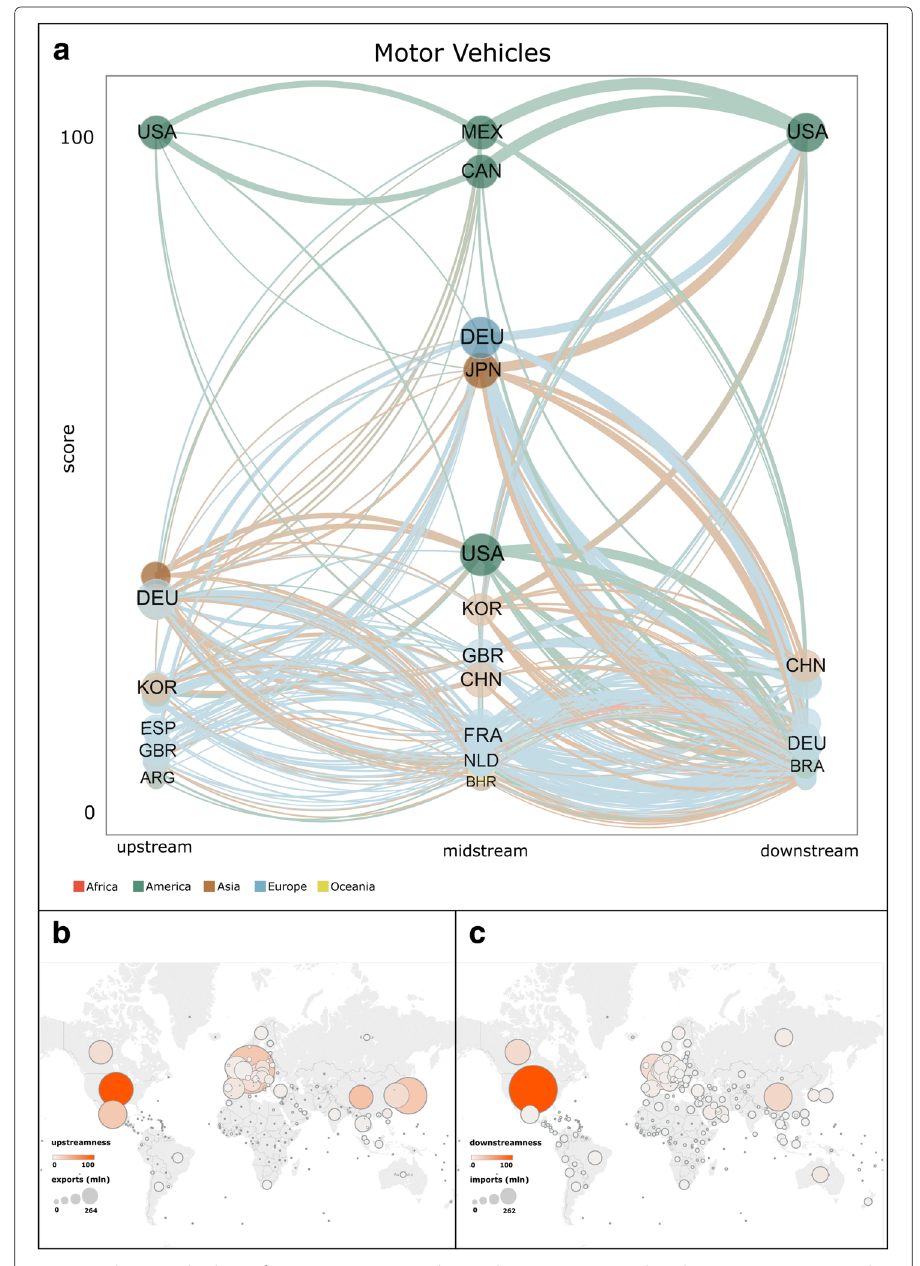
Fig. 6 Rankings and values of upstreamness centrality, midstreamness centrality, downstreamness centrality, exports, and imports of countries in the Motor Vehicles industry in 2014. In panel ( a ), the size of each node (country) in the network is proportional to the sum of the country’s exports of intermediate inputs (upstream), the sum of the country’s imports of intermediate inputs and exports of final products (midstream), and the sum of the country’s imports of final products (downstream). For each centrality measure, countries are ranked according to the corresponding score (highest at the top). Each directed link connects a country in set U to a country in set M , or a country in set M to a country in set U , according to the definition of the tripartite network given in the text. The width of each link is proportional to the value of products exchanged by the two connected countries. The colour of each link refers to the continent of the country from which the link originates. Panels ( b ) and ( c ) show the geographic map in which each country is represented as a circle whose diameter is proportional to the country’s total exports (panel ( b )) and total imports (panel ( c )), and whose colour varies according to the corresponding value of upstreamness (panel ( b )) and downstreamness (panel ( c )) centralities. The network in panel ( a ) was visualised through VOS Viewer. Maps in panels ( b ) and ( c ) were visualised using Tableau